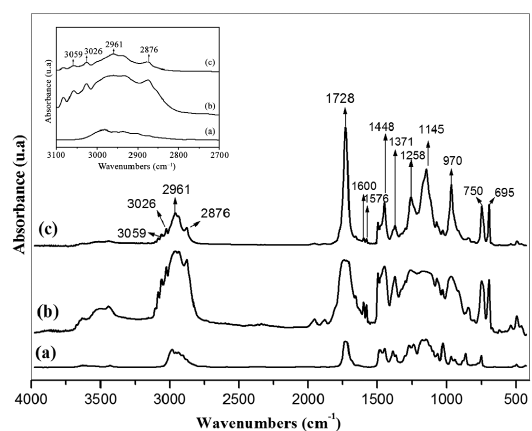
Figure 1. FTIR spectra of PEMA (a), PCMA (b) and PCMAEMA at 50:50 composition in the feed